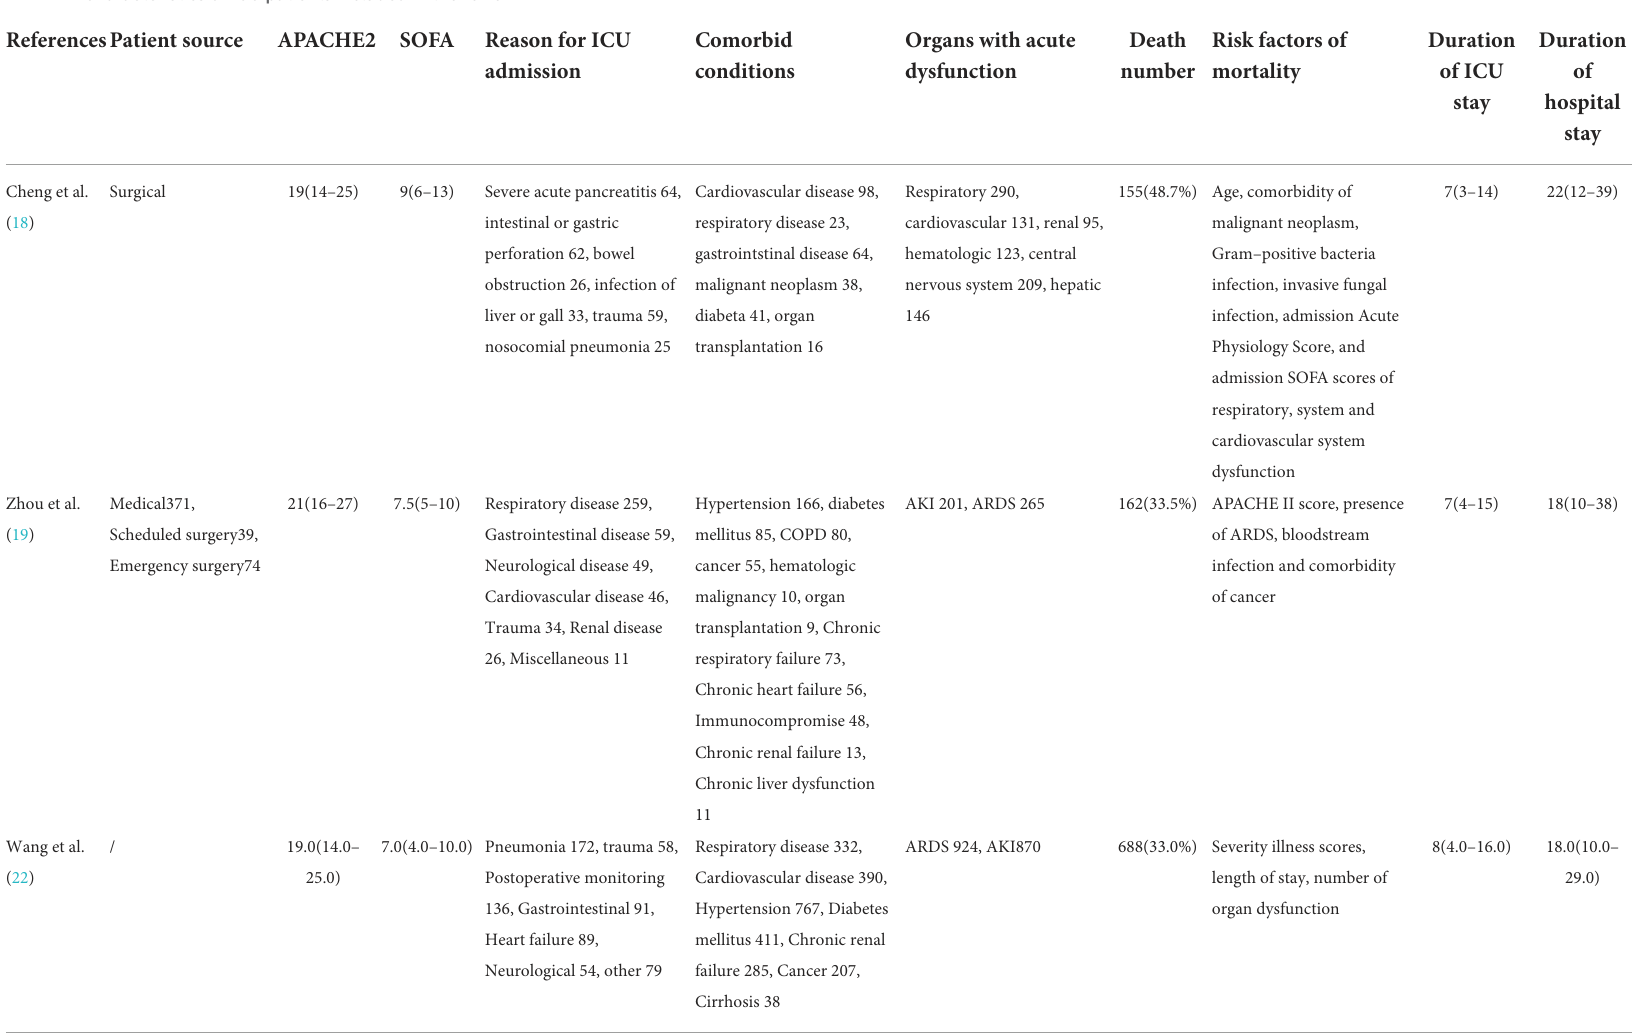
TABLE 2 Characteristics of ICU patients included in the